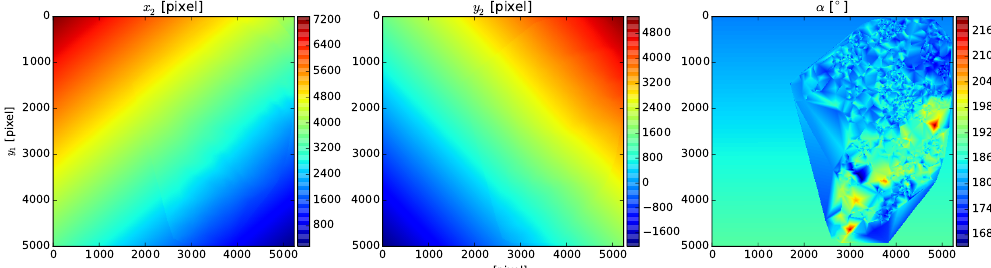
Figure 6. Example of estimated drift and rotation (first guess) based on filtered feature-tracking vectors using image pair Fram Strait in HV polarisation. The three panels show the components x 2 , y 2 of the estimated end positions and the estimated rotation α for each pixel on the coordinate system x 1 , y 1 of the first image (SAR 1